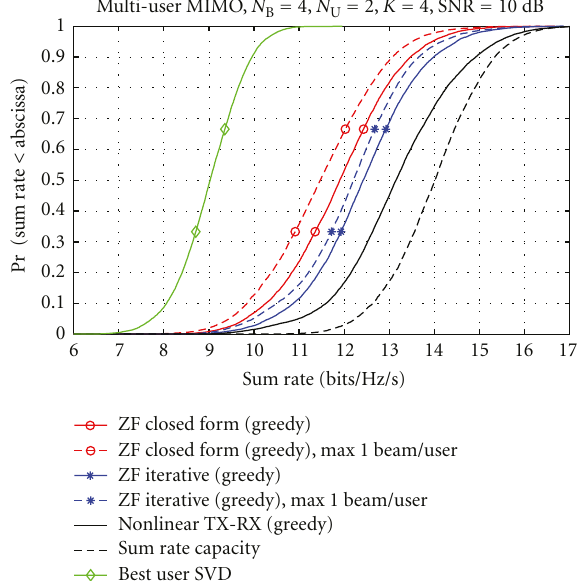
Figure 6: CDF of sum rate, with ideal CSI, N B = 4, N U = 2, K = 4, D S = 0.